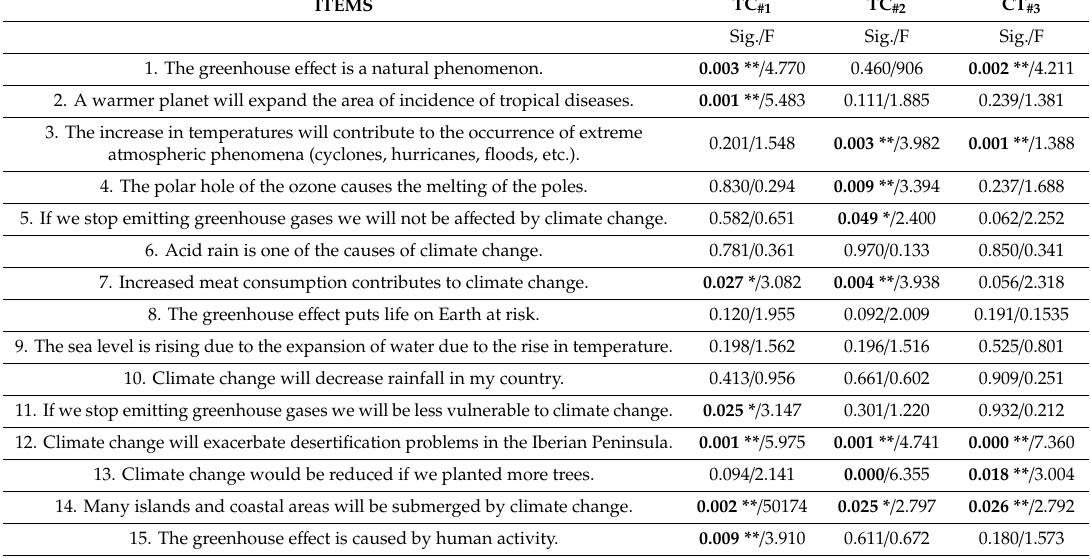
Table 11. To what extent do you feel informed about the causes of